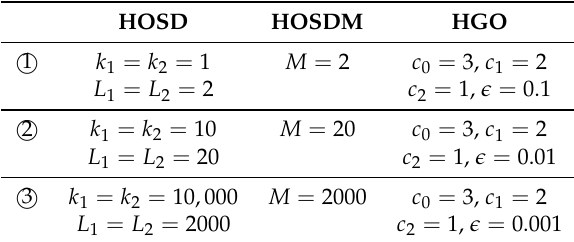
Table 1. Simulation parameter